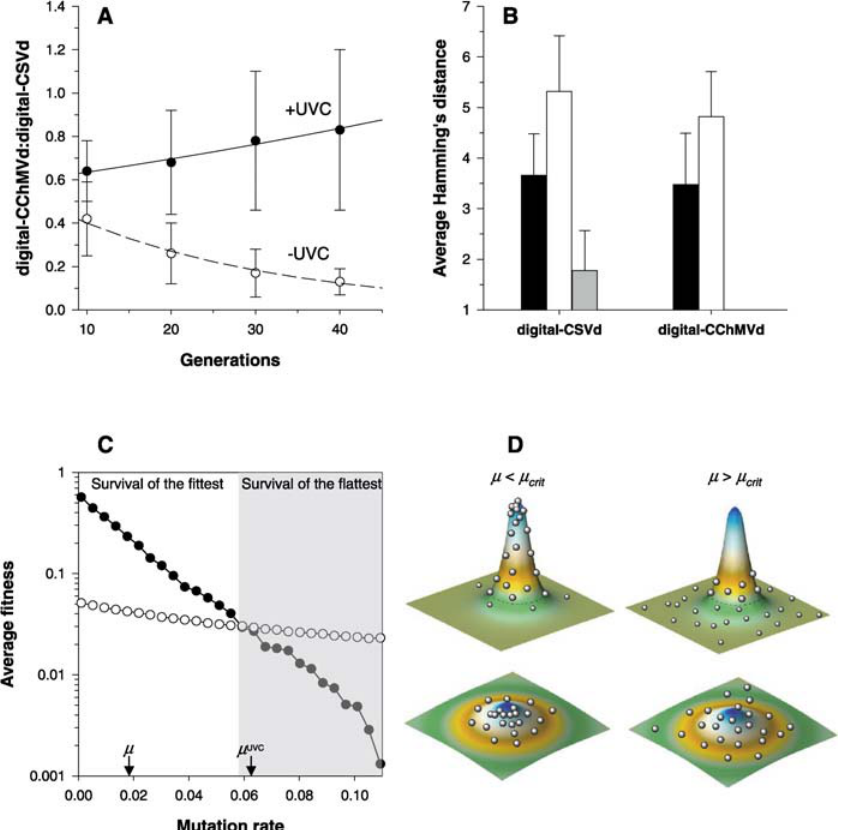
Figure 3. Results from the Simulation Model of Competing Bit String Populations The best solution obtained by searching over parameter space is shown ( s CSVd ¼ 0.33, s CChMVd ¼ 0.05, l ¼ 0.016, l UVC ¼ 0.063, and k c ¼ 3). (A) Population dynamics under control and UVC conditions, sampled over five different replicates over 40 generations. S ik (cid:1) S jk j among sampled digital viroids ( 6 SEM). Solid bars correspond to the control conditions, open (B) Average Hamming distance D H ¼ P m k ¼ 1 j bars to UVC conditions, and gray bars to UVC conditions after exclusion of the 66.5% CSVd lethal genotypes from the computations. (C) The survival-of-the-flattest effect is shown here using the two populations that evolved separately with increasing mutation rates. The average fitness for each population is plotted against mutation rate. Using the above s CSVd , s CChMVd , and k c values, the mutation rate was allowed to vary from l ¼ 0.001 to l ¼ 0.15. At a given critical mutation rate (here l crit ¼ 0.059), the average fitness of digital-CSVd (solid dots and continuous line) starts to decay below the one shown by digital-CChMVd (open dots and dashed line). The domain where the flattest wins over the fittest is indicated as a gray area. (D) Shows a cartoon interpretation of the observed effect of high mutation rate on average fitness and variability.